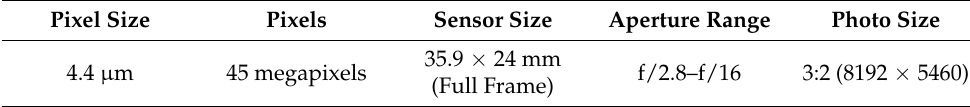
Table 2. DJI Zenmuse P1 photogrammetric camera main